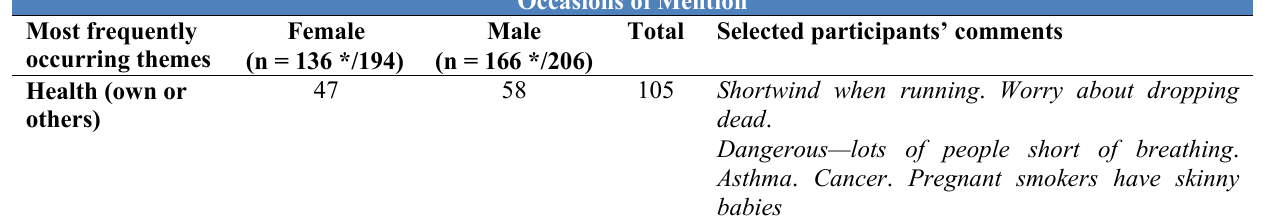
Table 2. Top End Tobacco Project community baseline survey: participants’ responses to questions regarding (i) their concerns about tobacco use and (ii) suggestions to reduce tobacco